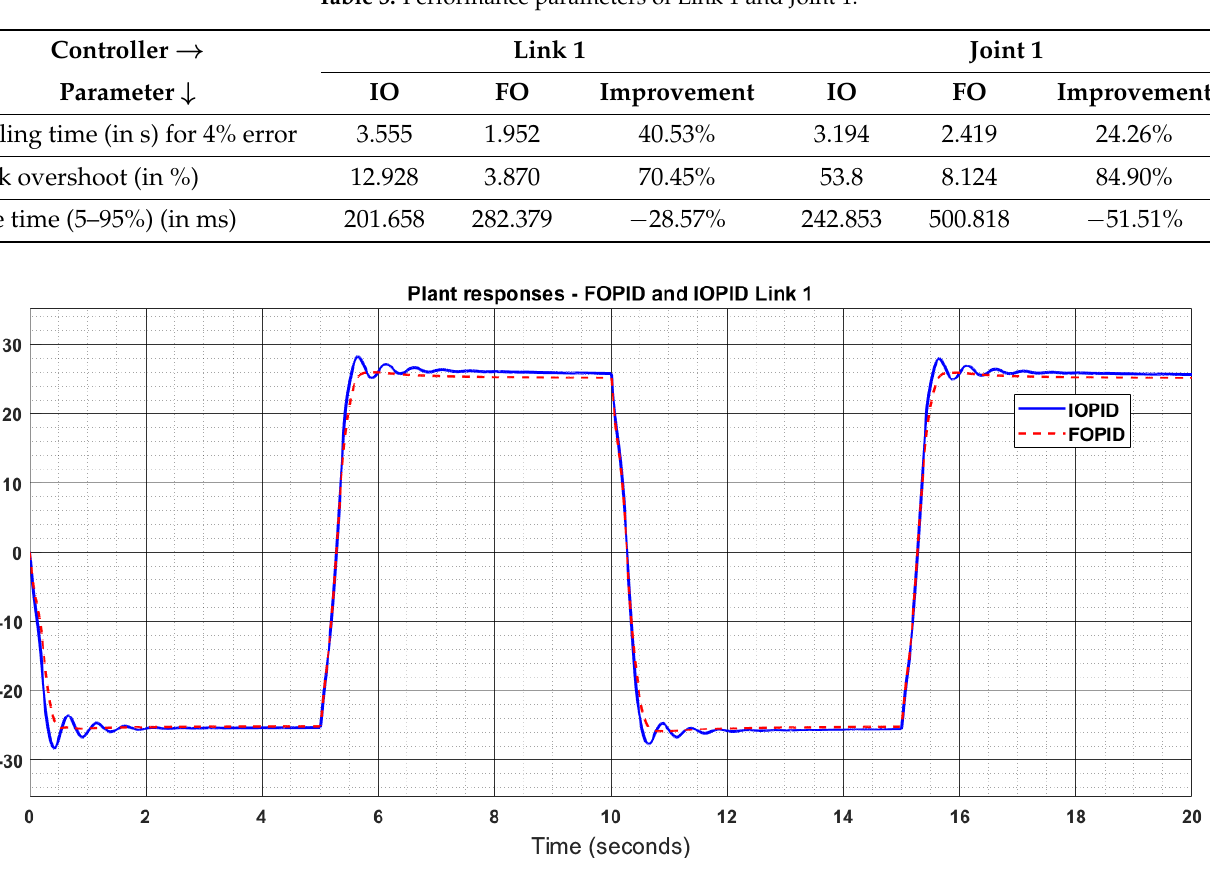
Figure 7. Controller responses for angular position ( θ ) for Link